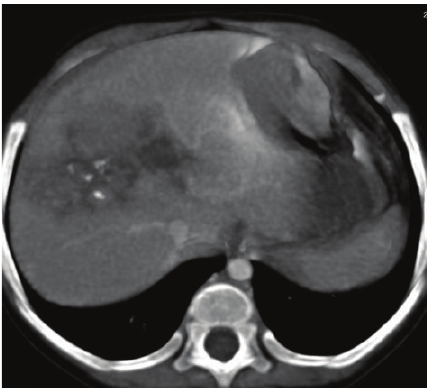
Figure 3: Postchemotherapy CT image shows a heterogeneously enhancing soft tissue density lesion of size 45 × 65 mm, with internal foci of calcification involving right lobe of